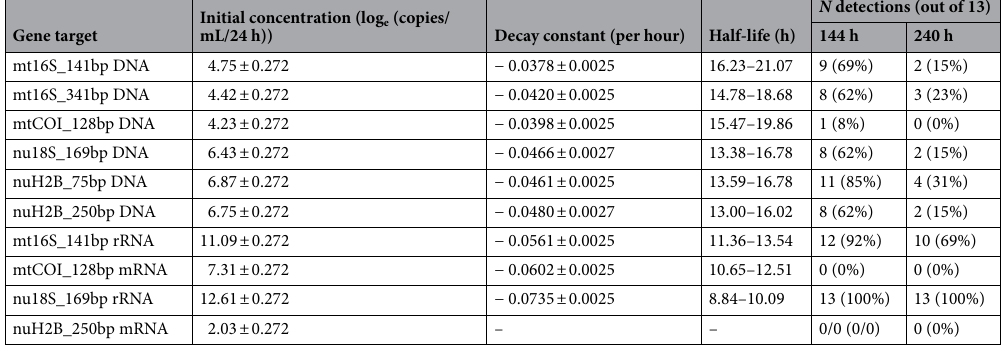
Table 2. Initial concentration released over 24 h, linear mixed-effect model decay constants (± SE), half-life range estimated from 95% confidence interval, and number ( N ) of detections at 144 and 240 h for each gene target across eDNA and